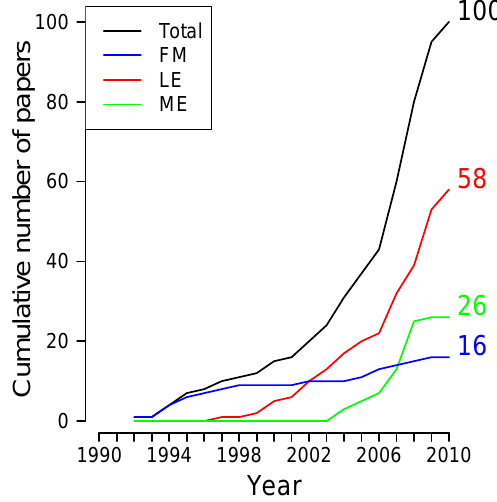
Figure 2. Total number of publications (Total) included in the database, including field measurements (FM), as well as laboratory (LE) and mesocosm experiments